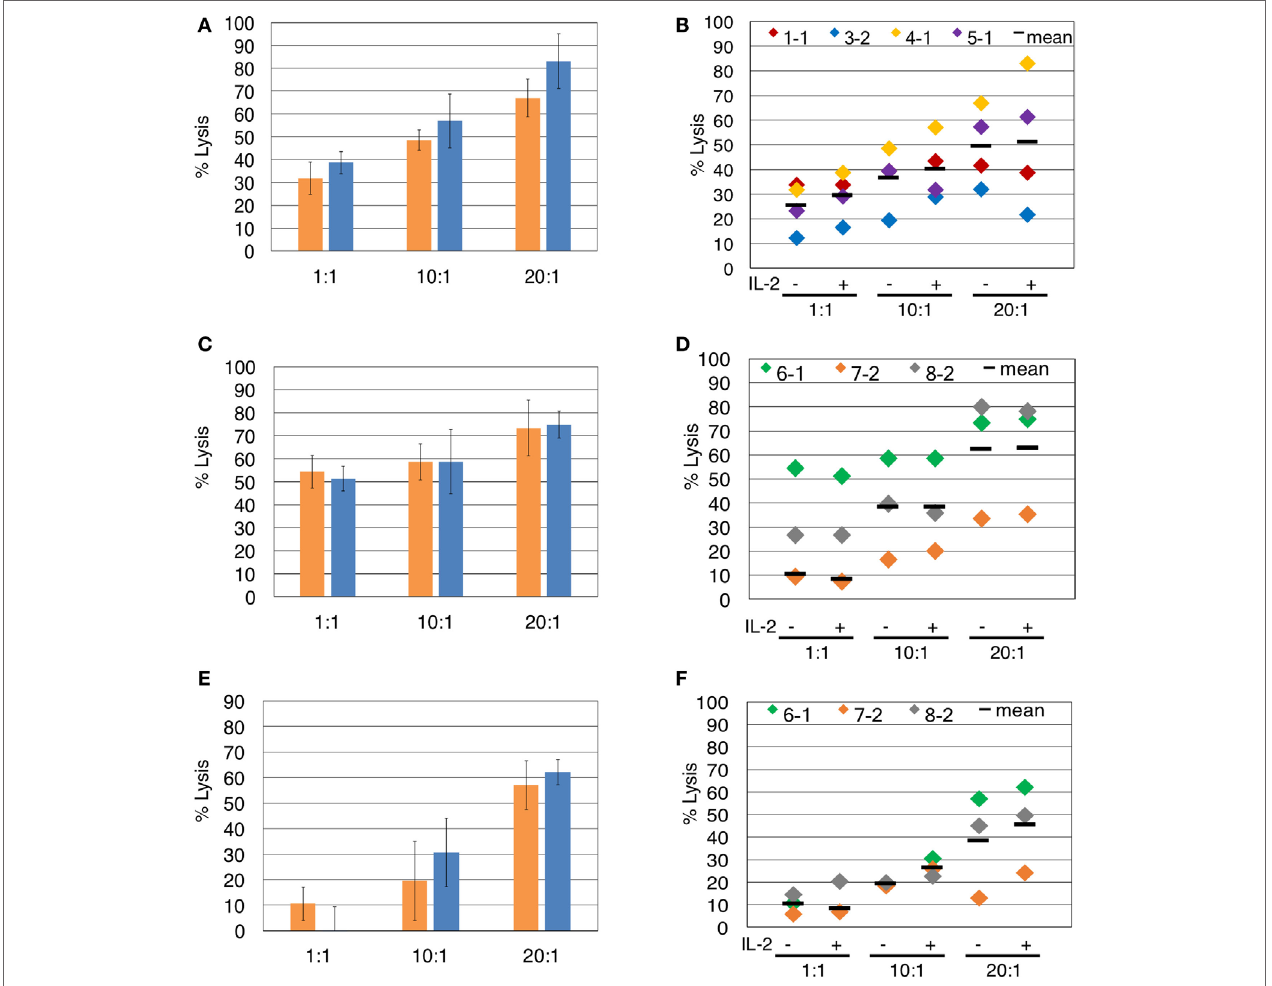
FigUre 3 | The presence of interleukin-2 (IL-2) does not significantly impact γδ Tc cytotoxicity against breast cancer cell lines. Comparison of γδ T cell cytotoxicity, at the indicated effector:target ratios, in the absence (orange) or presence (blue) of IL-2, against (a) T47D (Donor 4, culture 1, day 21 γδ T cells), representative of four independent experiments. (B) Compiled results of four independent cytotoxicity experiments using T47D cells as targets. (c) MCF-7 (Donor 6 day 19 γδ T cells), representative of three independent experiments. (D) Compiled results of three independent cytotoxicity experiments using MCF-7 cells as targets. (e) MDA-MB-231 breast cancer cell targets (Donor 6 day 19 γδ T cells). (F) Compiled results of three independent cytotoxicity experiments using MDA-MB-231 cells as targets. Two-way ANOVA followed by Bonferroni’s multiple comparisons analysis were performed for all experiments; no significant differences were